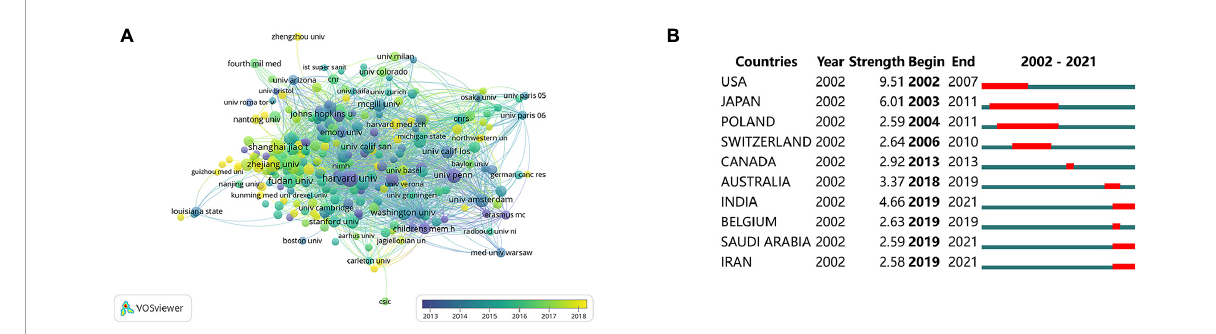
FIGURE4 Contributions of countries/regions to mammalian target of rapamycin in neuroscience studies. (A) Organizations with co-occurrence relations shown as an overlay graph plotted using VOSviewer 1.6.14. (B) Countries/regions with the strongest citation bursts (strong citation bursts indicate that a variable has changed dramatically in a short time; the red bar indicates the duration of the outbreak).